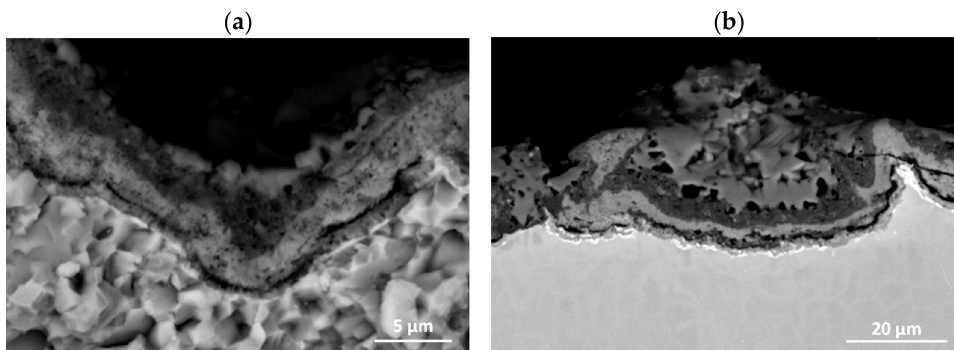
Figure 20. SEM-BSE images of Ti–46Al–7Nb–0.7Cr–0.1Si–0.2Ni alloy after cyclic oxidation at 975 °C (surface prepared by abrasive blasting): ( a ) high-magnification, ( b ) low-magnification. XRD phase analysis results for Ti–46Al–7Nb–0.7Cr–0.1Si–0.2Ni after oxidation at 875 °